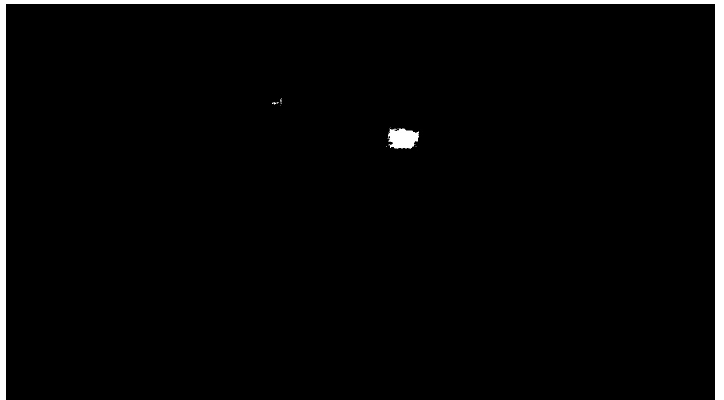
Figure 7. Highlight of a moving object.